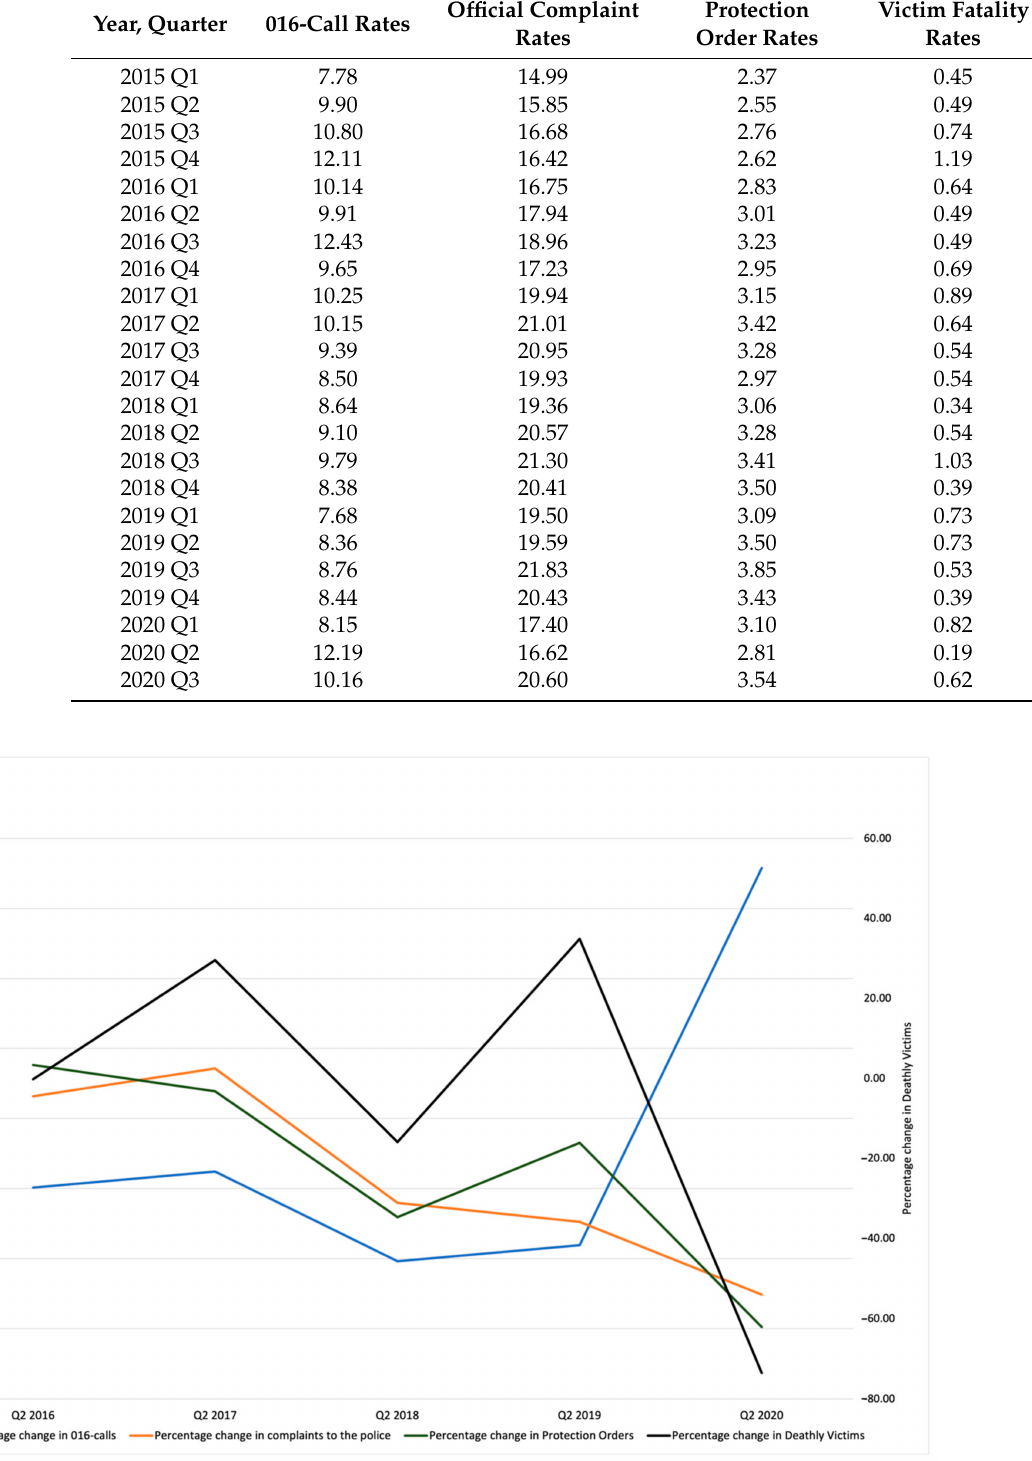
Figure 1. Interannual percentage change in 2nd-trimester rates for the four gender-violence